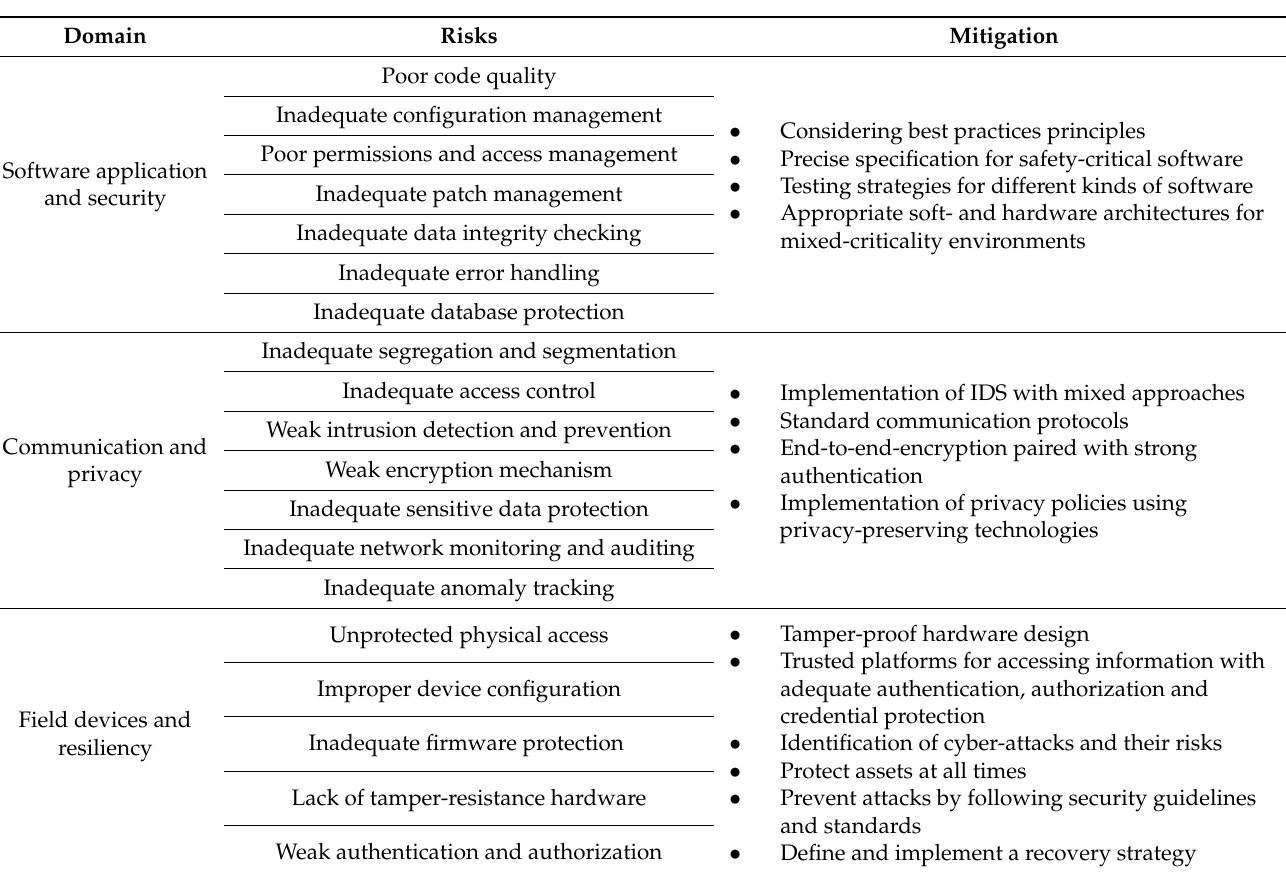
Table 10. Common weaknesses and remedies for microgrid security